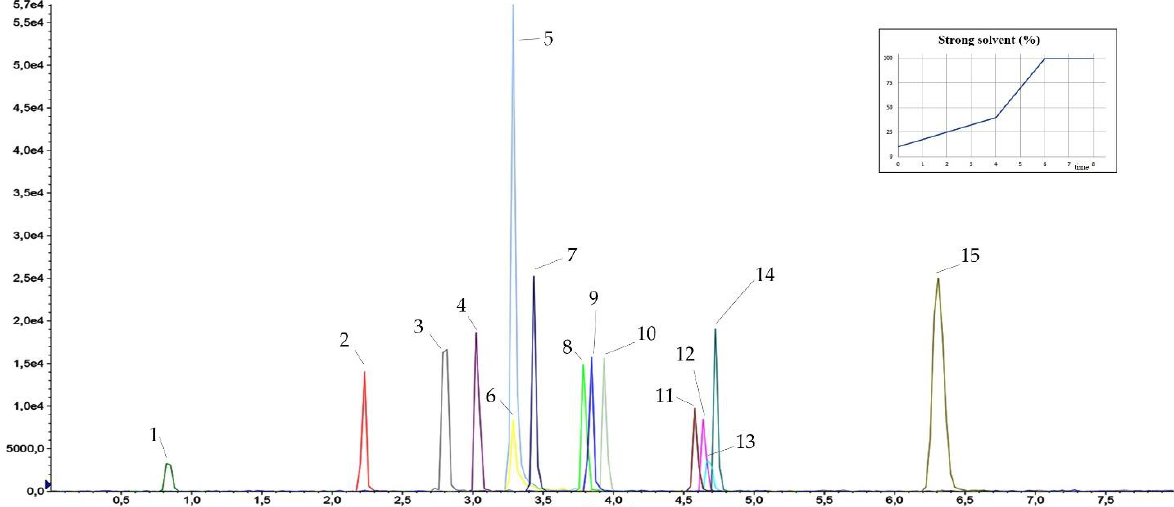
Figure 6. Chromatogram (10 pg injected) obtained with the final conditions (see paragraph ‘Liquid chromatography and mass spectrometry’) the scheme showed the strong solvent (CH 3 CN) percentage trend during the run. Peaks names: 1 atenolol, 2 tramadol, 3 venlafaxine, 4 zolpidem, 5 triprolidine, 6 bromazepam, 7 trazodone, 8 fentanyl, 9 diphenhydramine, 10 escitalopram, 11 cetirizine, 12 cyproheptadine, 13 alprazolam, 14 delorazepam, 15 ebastine.